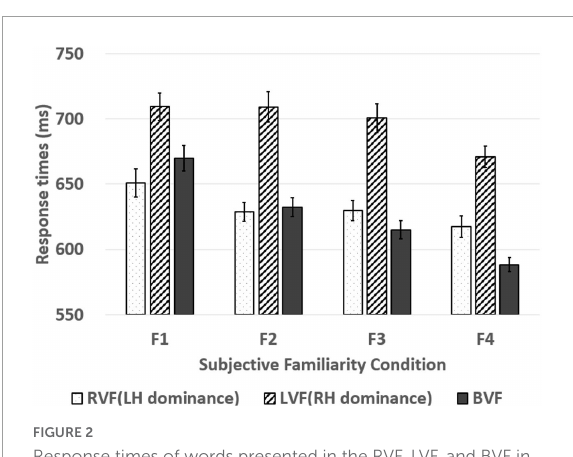
FIGURE2 Response times of words presented in the RVF, LVF, and BVF in four subjective familiarity levels. The four subjective familiarity levels indicate F1 ( M = 4.21, SD = 0.74), F2 ( M = 4.61, SD = 0.91), F3 ( M = 5.10, SD = 0.75), and F4 ( M = 5.46, SD = 0.78). The line in the bar graph denotes the range of standard